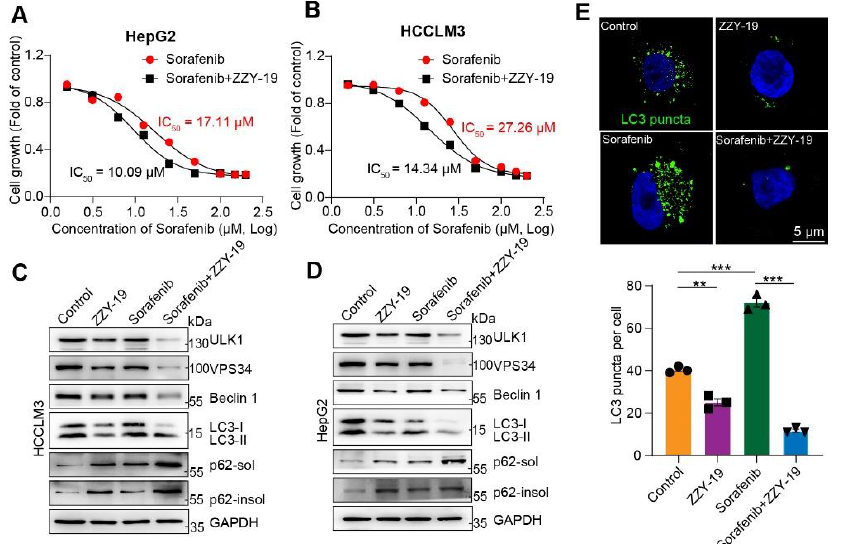
Figure 7. ZZY-19 induces autophagy inhibition by reducing the expression of the ULK1 and acts synergistically with sorafenib ( A , B ) Effects of ZZY-19 on the proliferation of HepG2 and HCCLM3 cells. The data showed a summary of the IC 50 values for sorafenib in HepG2 or HCCLM3 cells. ( C , D ) The effects of ZZY-19 and/or sorafenib on the proteins related to autophagy. HepG2 and HCCLM3 cells were treated with ZZY-19 (10 µ M), sorafenib (10 µ M), or ZZY-19 plus sorafenib. The proteins were detected by immunoblotting. Data are representatives of three independent assays. ( E ) Representative images of HepG2 cells infected with GFP-LC3 adenovirus treatment with ZZY-19 (10 µ M), sorafenib (10 µ M), or ZZY-19 plus sorafenib for 24 h. Scale bar, 5 µ m. ** p < 0.01; *** p < 0.001.